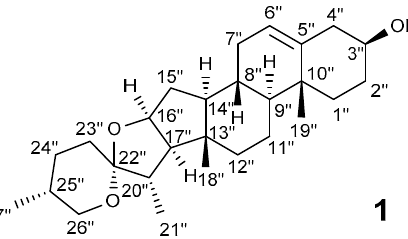
Figure 1. Structure of diosgenin ( 1 ). Note: carbon atoms are double-primed as in evaluation of the NMR spectra of diosgenin derivatives .